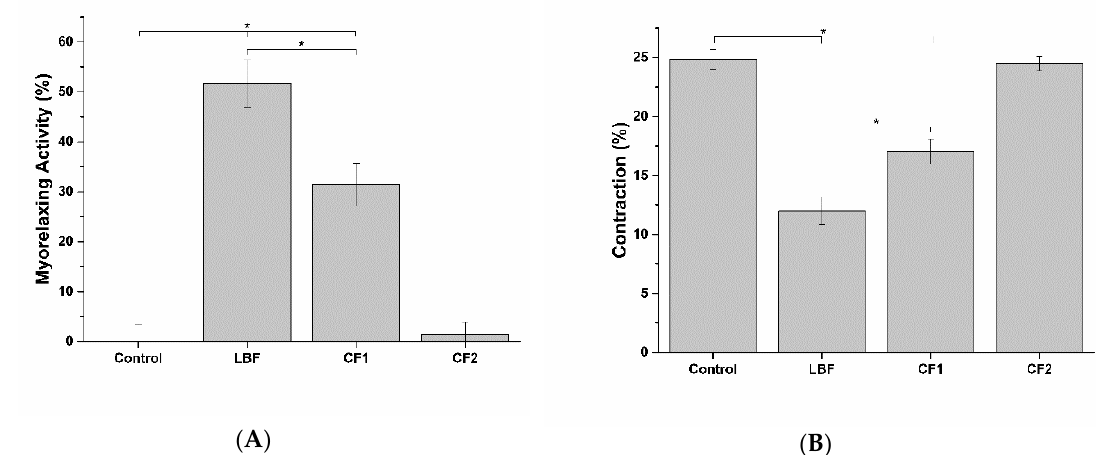
Figure 20. Myorelaxing ( A ) and contraction inhibitory ( B ) activity of the bioaccessible fraction of the different formulations on an in vitro model of smooth muscle. * p < 0.05 (n = 3).